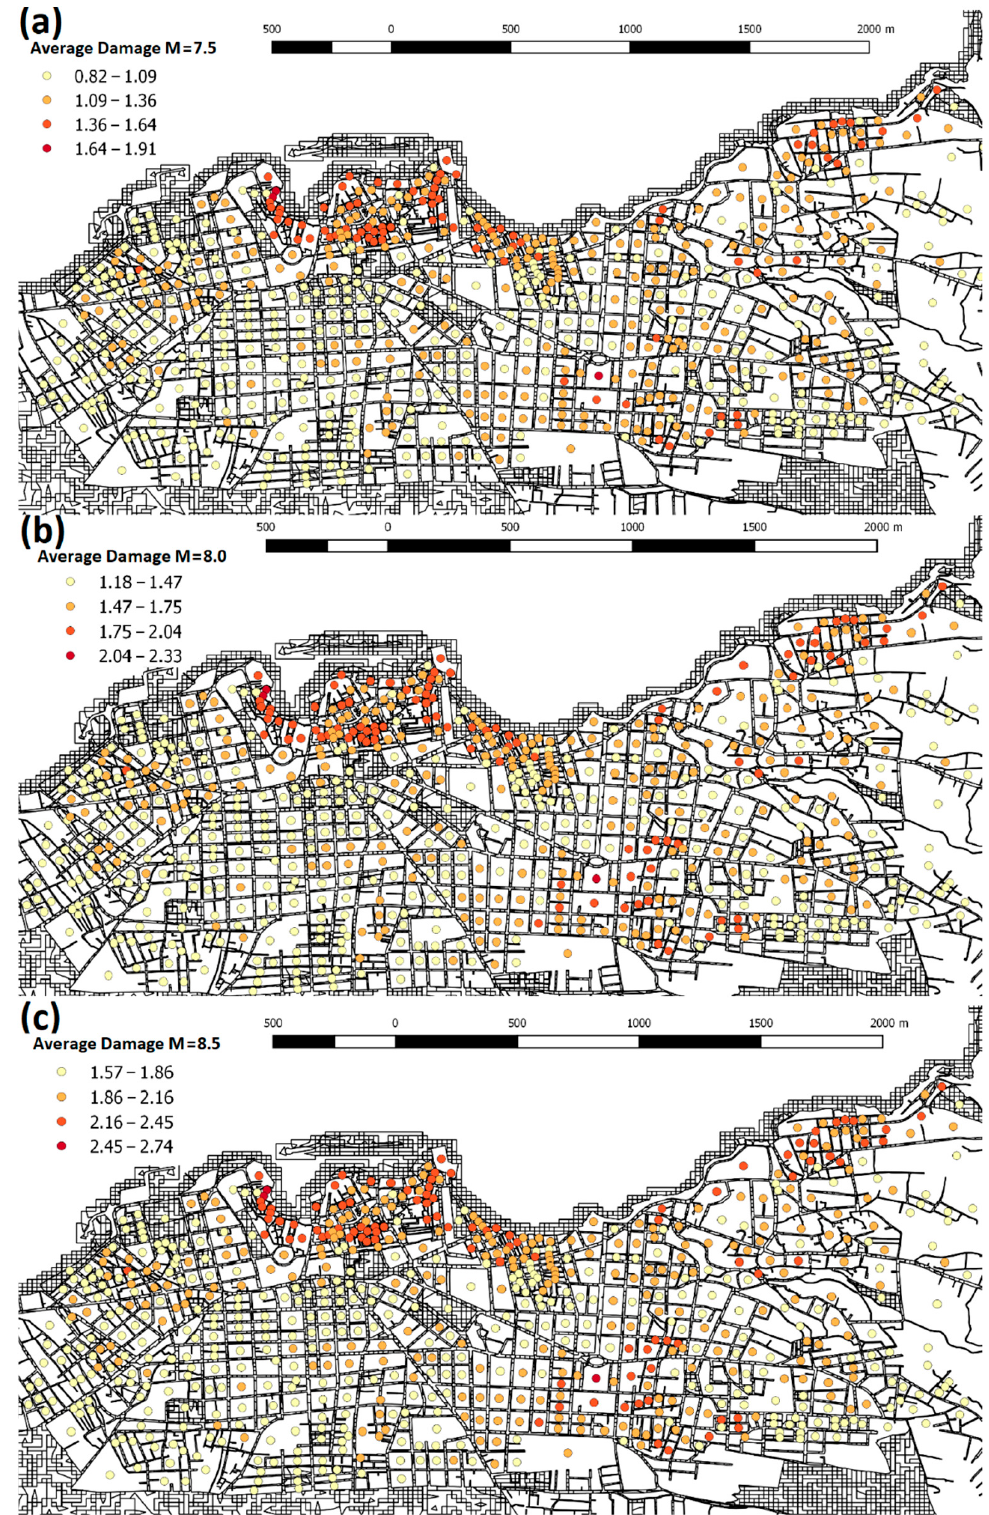
Figure 10. Estimated average degree of damage per building block under extreme seismic events: ( a ) M w =7.5, ( b ) M w =8.0, and ( c ) M w =8.5. ( a ) M w = 7.5, ( b ) M w = 8.0, and ( c ) M w =